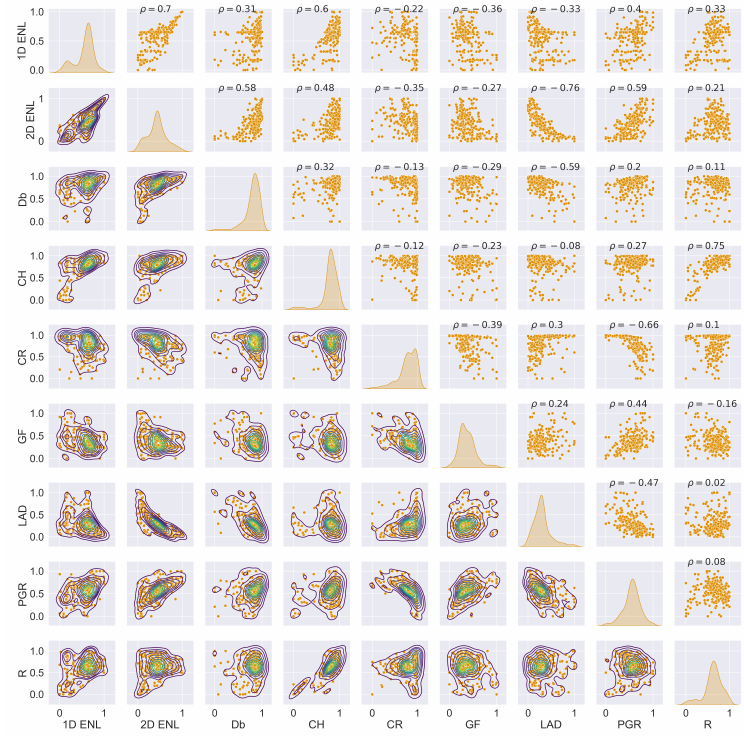
Figure A40. TLS traits plot at 5m grid